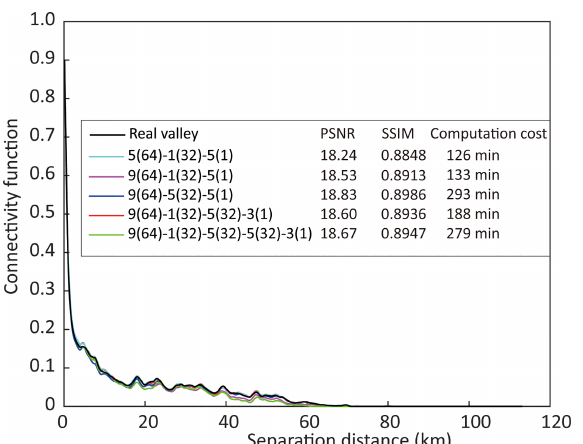
Figure A7. Connectivity of paleovalley generated by SRCNN with multiple depths and filter sizes. Computation cost is the time taken to train the